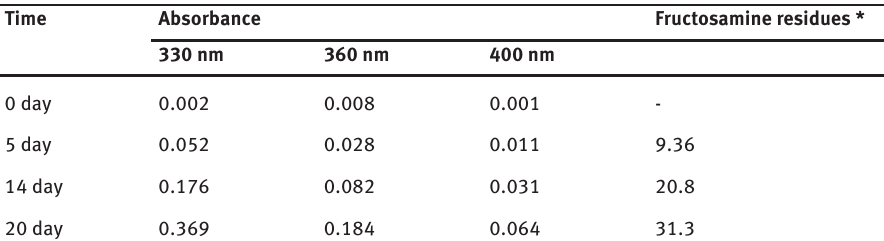
Table 1: The results of UV measurements and fructosamine contents of HSA incubated with glucose. Time